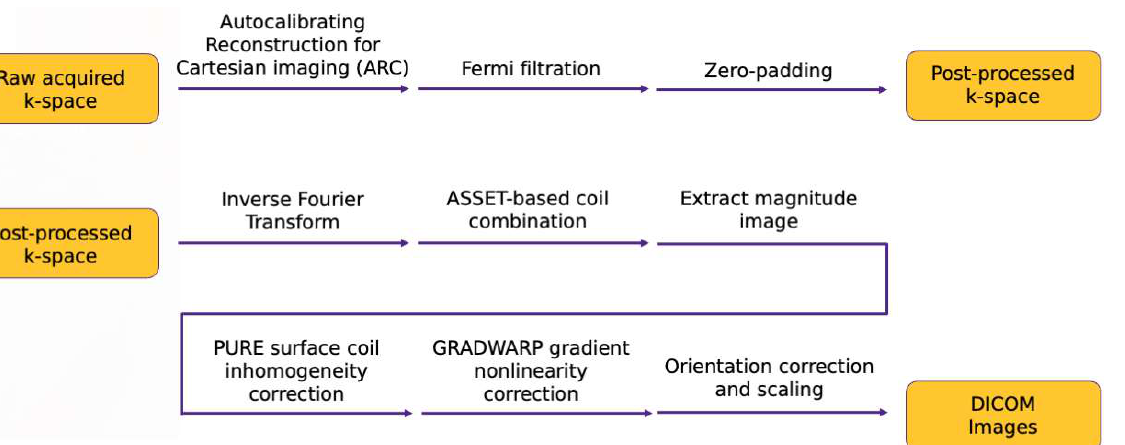
Figure 3. Intermediate outputs within the post-processing pipeline going from raw k-space to DICOM images. Each pane of the image reflects the output of the image after the step described by the pane title.